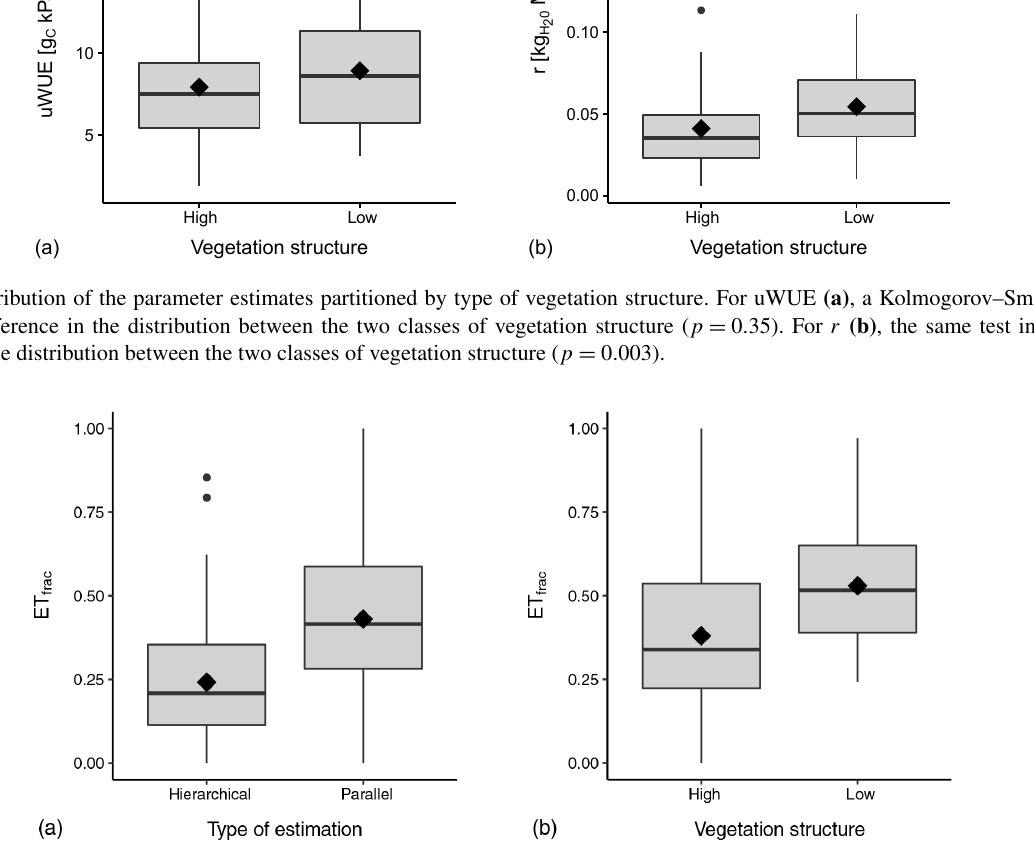
Figure 7. Distributions of ET frac estimates for all sites. The diamonds indicate the mean and the bold horizontal lines indicate the median. The hierarchical approach yielded substantially lower values and can be interpreted as a conservative estimate of the quantity (a) . ET frac was significantly higher at sites with low-vegetation structure (b)